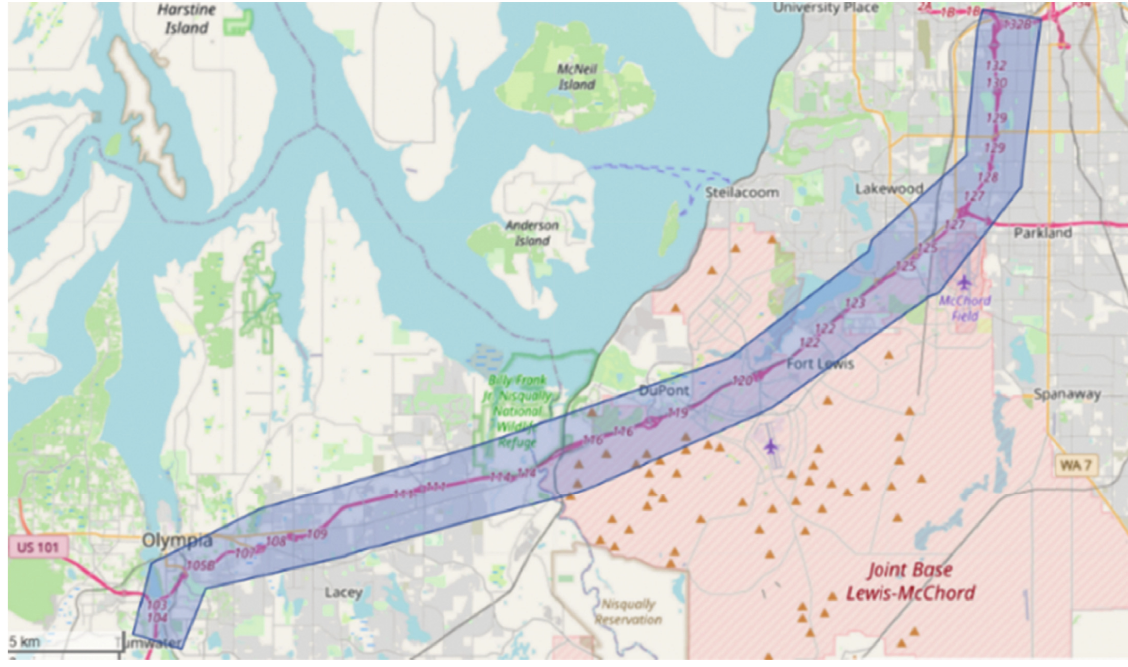
Figure 1: Study section of freeway.